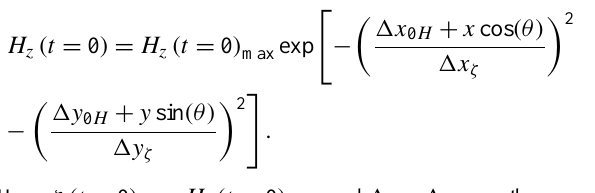
Fig. 4. Excitation of PEMW by means of vertical component of magnetic vortex. The spatial distributions of normalised ζ and components of magnetic field (H x ,H y ,H z ) are taken at hight Z = 300km (night-time). Amplitudes of initial excitations are equal to ζ(t = 0 ) max = 0 . 01 and H z (t = 0 ) max = 0 . Dimensionless size of the source are ∆ x ζ = ∆ y ζ = 0 . 17 . The scaling of X , Y and normalised values of H are the same as in Fig. 3.